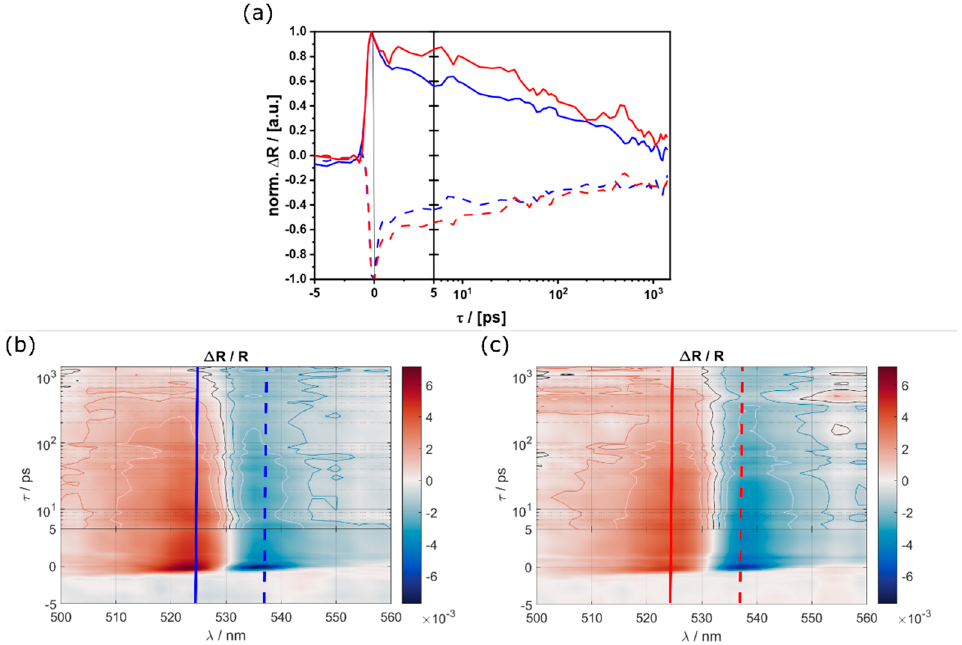
Figure 11. ( a ) Differential reflection transients at 524 nm (solid lines) and 537 nm (dashed lines) for CU (red) and RD (blue) particles; and full transient reflection maps measured on individual ( b ) (110) and ( c ) (100) facets, vertical lines corresponding to ( a ), contour lines at longer delay times indicate steps of 10 − 3 .